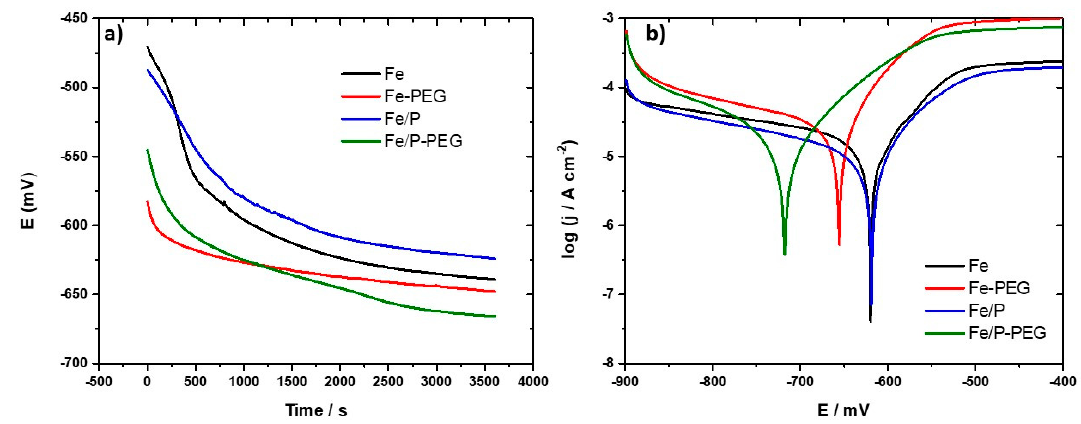
Figure 4. Open circuit potentials (OCP) curves ( a ) and potentiodynamic polarization curves ( b ) of iron-based foams (Fe, Fe-PEG, Fe/P, and Fe/P-PEG) in Hanks’ solution. Table 4. Electrochemical data and corrosion rate ( CR ) of iron-based foams (Fe, Fe-PEG, Fe/P, and Fe/P-PEG) in Hanks’ solution.